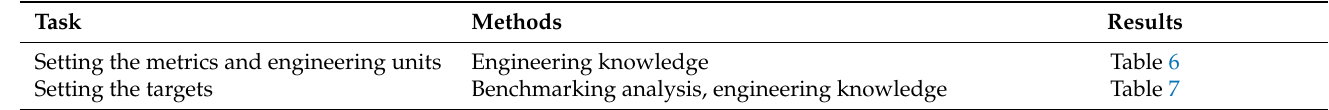
Table 8. Summary of tasks and methods adopted in the Preliminary specifications setting